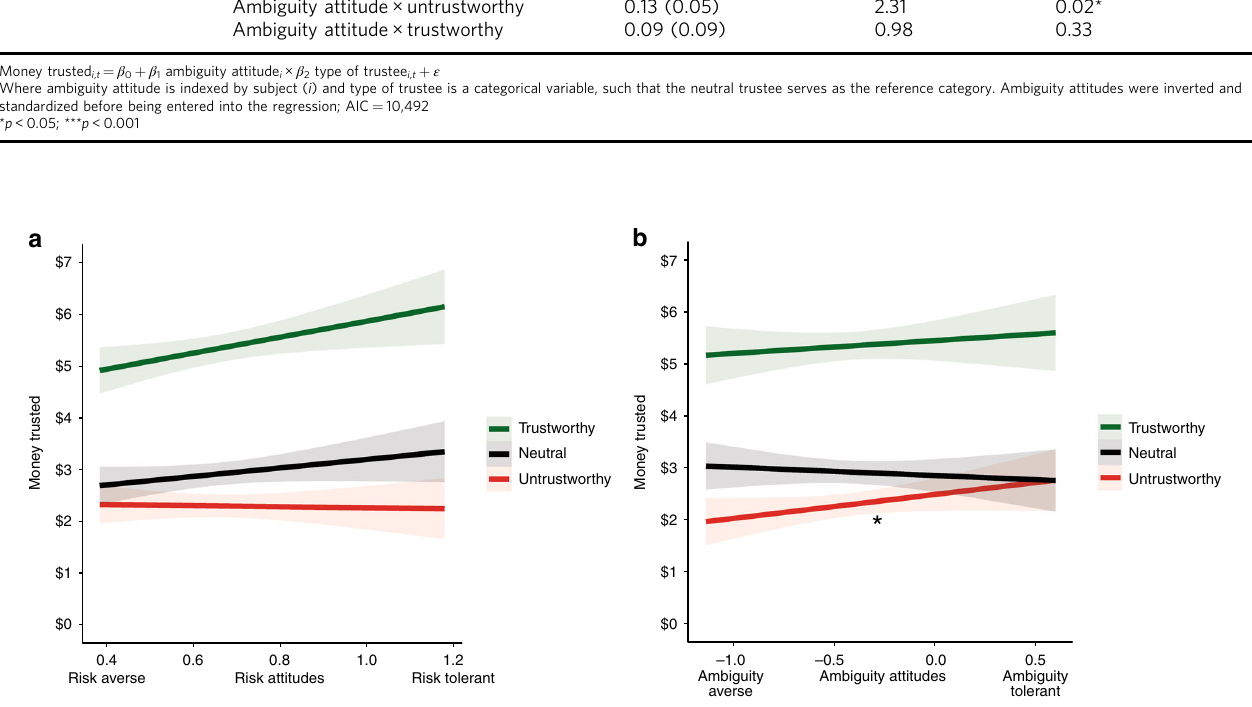
Fig. 3 Experiment 2 results. a Risk attitudes do not modulate trusting behavior. b A regression reveals that ambiguity attitudes modulate the amount of money entrusted in the untrustworthy trustee but does not modulate money trusted in the trustworthy or neutral trustee. Ambiguity attitudes are inverted to align on the same scale as risk attitudes for presentation purposes. Fitted regression lines are plotted. Asterisks indicate signi fi cant differences (* p < 0.05). Error bars re fl ect 95%